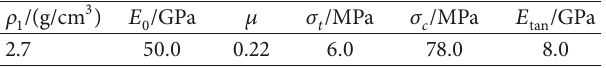
Table 2: Rock mass physical and mechanical material.